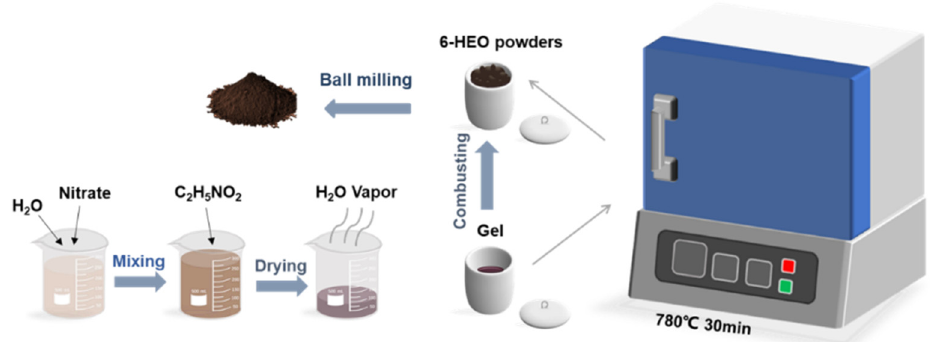
Figure 1. Illustration for the preparation processes of the 6-SHEO powders .